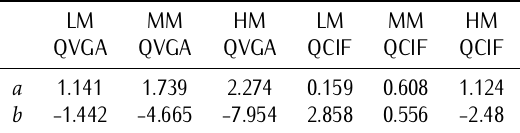
Table 5. Experimental coefficients for the fitting